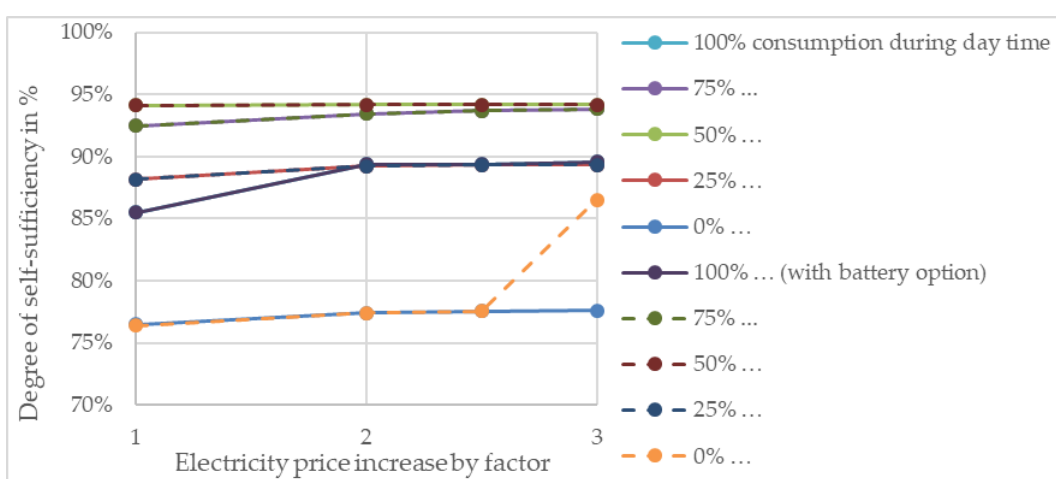
Figure 12. Degree of self-sufficiency for investing in PV and wind turbines (Sc_I.2) with and without batteries. Table 9. Costs of farm’s power supply with combined PV and wind,